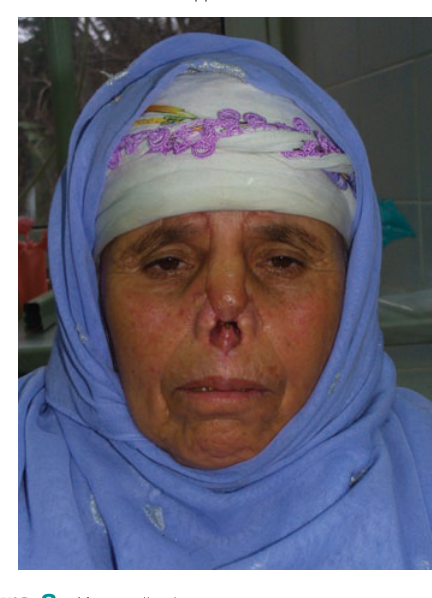
Figure 2. Case 1 before